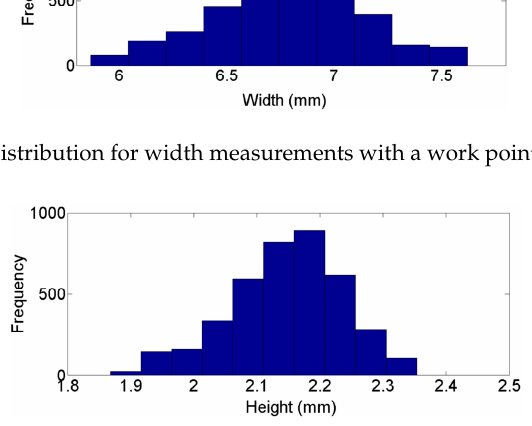
Figure 15. Frequency distribution for height measurements with a work point of 21 V and 6 m/min.